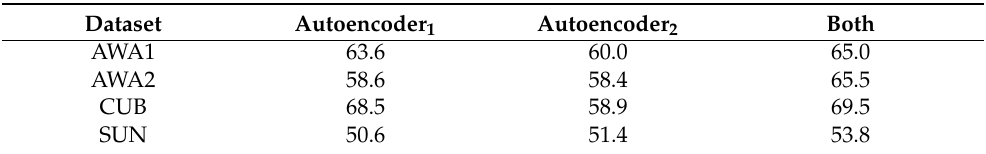
Table 3. Results for each autoencoder on four datasets under the ZSL setting. The performance is evaluated using the per-class average.